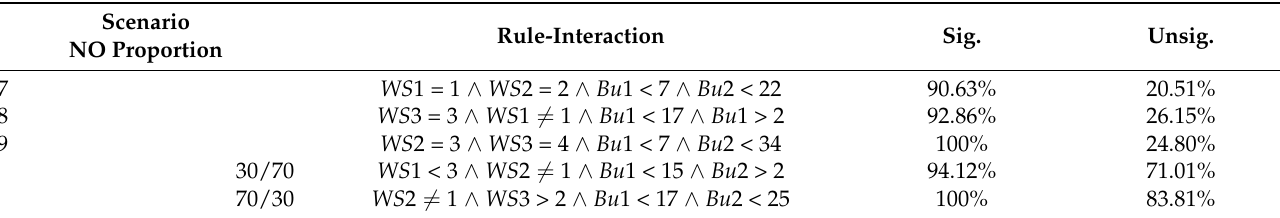
Table 6. Decision rules regarding workstations and buffer allocations.